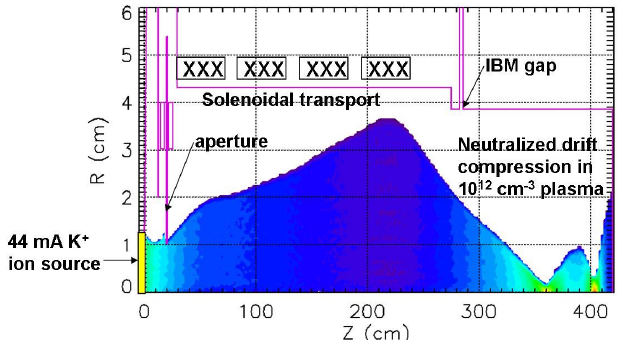
FIG. 1. (Color) The NDCX simulation geometry is shown with the beam density near the time of peak simultaneous compres- sion. From left to right, the ion source, diode, magnetic transport, IBM gap, and plasma regions are shown.